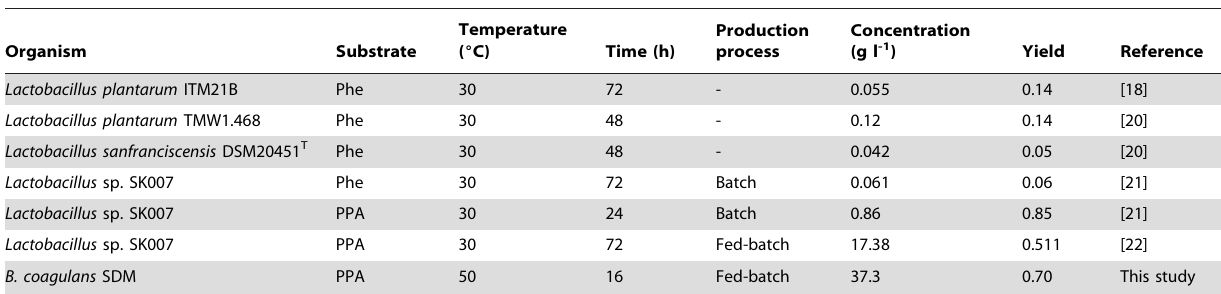
Table 3. Comparison of PLA production by bacteria.